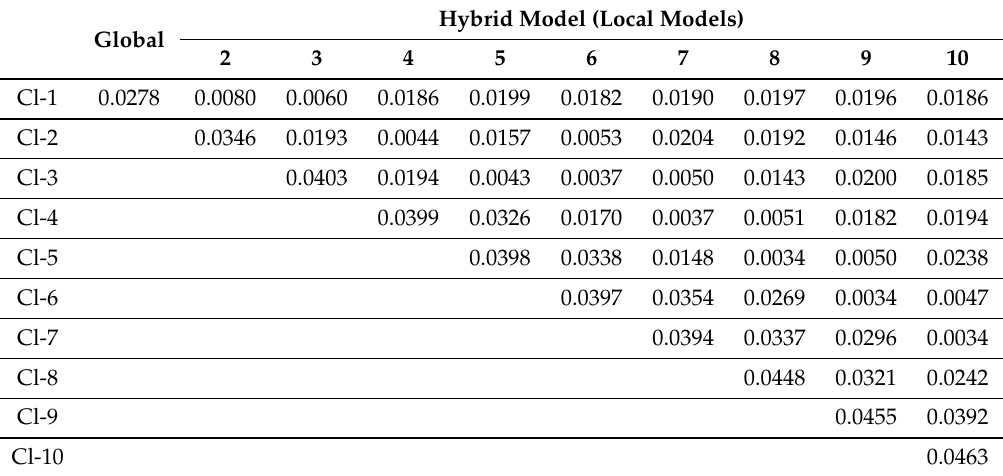
Table 5. Mean absolute error (MAE) for each individual hybrid model.